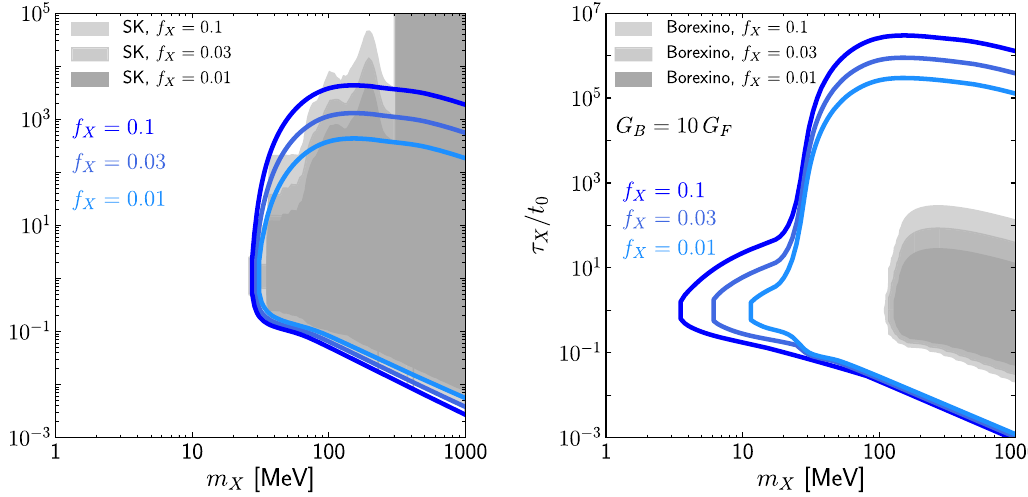
Fig. 4 Obtainable exclusion limits, for DR in form of SM neutrinos (baryonic neutrinos) in the left (right) panel, assuming f X = 0 . 1 , 0 . 03 , 0 . 01. The gray areas in the left (right) panel show excluded regions from SK (Borexino) for different f X and are taken from